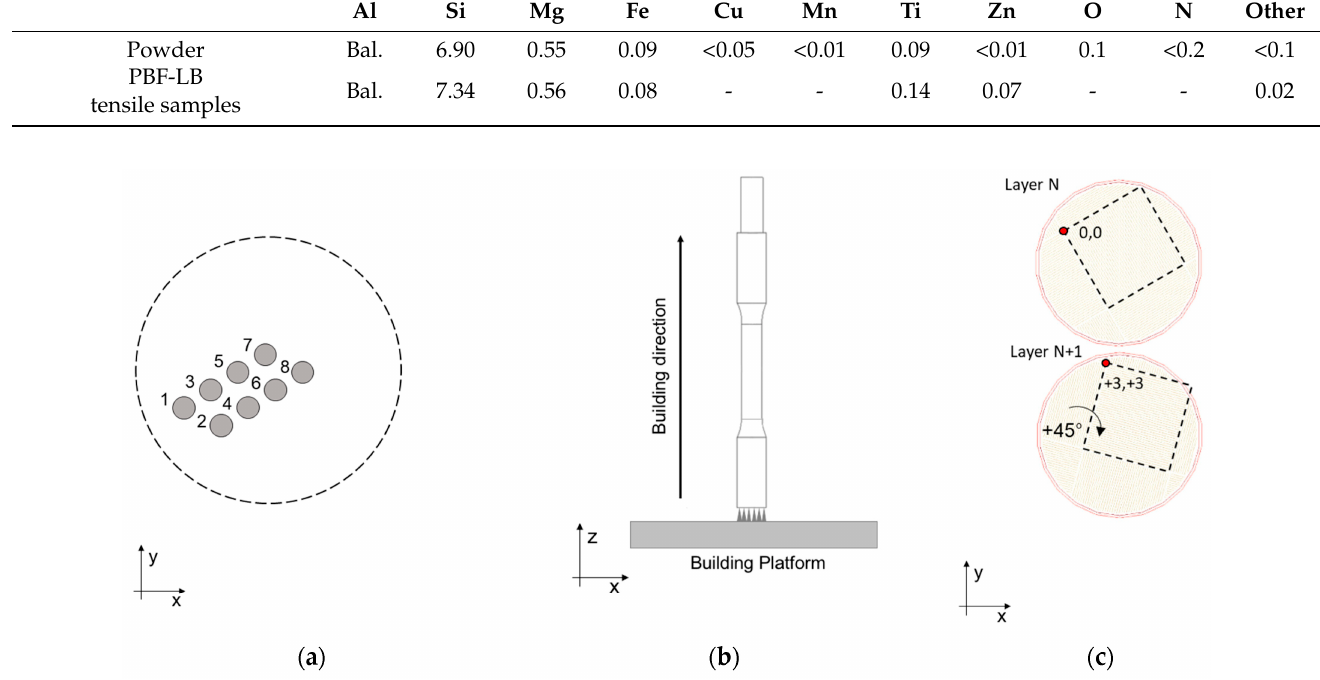
Figure 1. Tensile samples manufacturing: ( a ) printing position and scanning order; ( b ) building direction, ( c ) chessboard scan strategy. Table 2. PBF-LB process parameters used for tensile sample manufacturing.